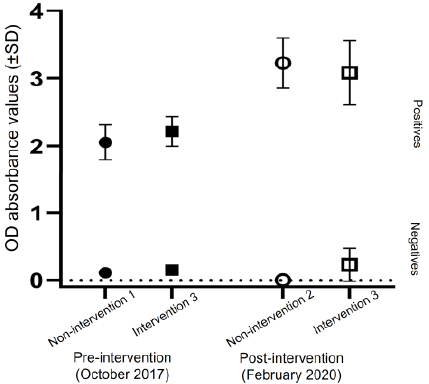
Figure 2. The comparison of the mean OD absorbance values obtained with the COM